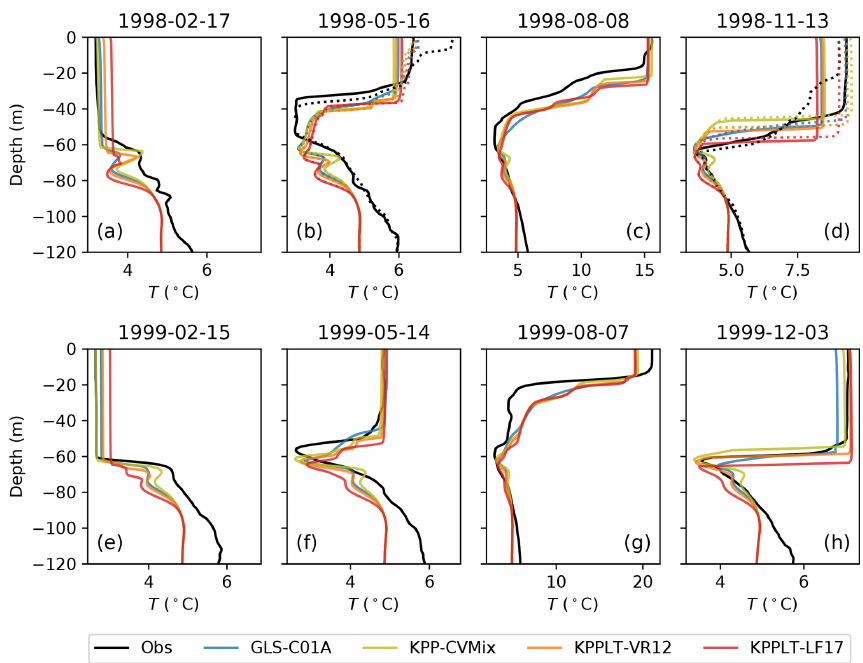
Figure 12. A comparison of the temperature profiles at the Gotland Basin between the observation (black) and GOTM simulations (colored). Profiles at eight time points (marked by gray diamonds in Fig. 11) are shown, representing two typical seasonal cycles. Dotted lines in panels (b) and (d) show another set of profiles 1 or 2d apart from the solid lines (see plus signs in Fig. 11d, e), highlighting the faster timescale variations.